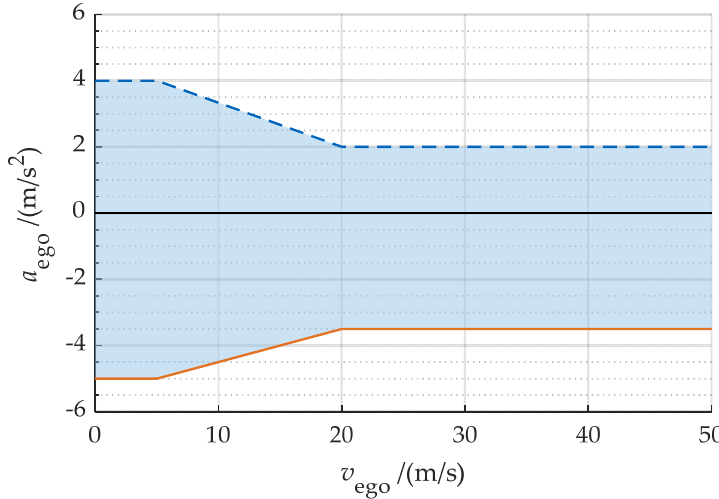
Figure 10. Upper and lower limits of acceleration according to ISO 15622:2018 [55].